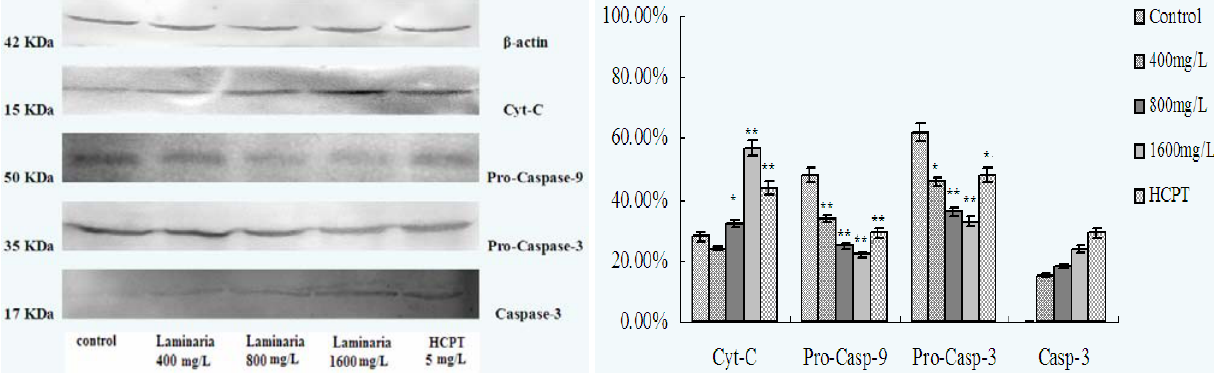
Figure 8. Effect of laminarin on Cyt-C, Caspase-9 and Caspase-3 expression in LOVO. ( A ) Cells were treated as control group; ( B ) Cells were treated with 400 µg · mL − 1 laminarin; ( C ) Cells were treated with 800 µg · mL − 1 laminarin; ( D ) Cells were treated with 1,600 µg · mL − 1 laminarin; ( E ) Cells were treated with 5 µg · mL − 1 HCPT. * p < 0.05, ** p < 0.01 vs . control